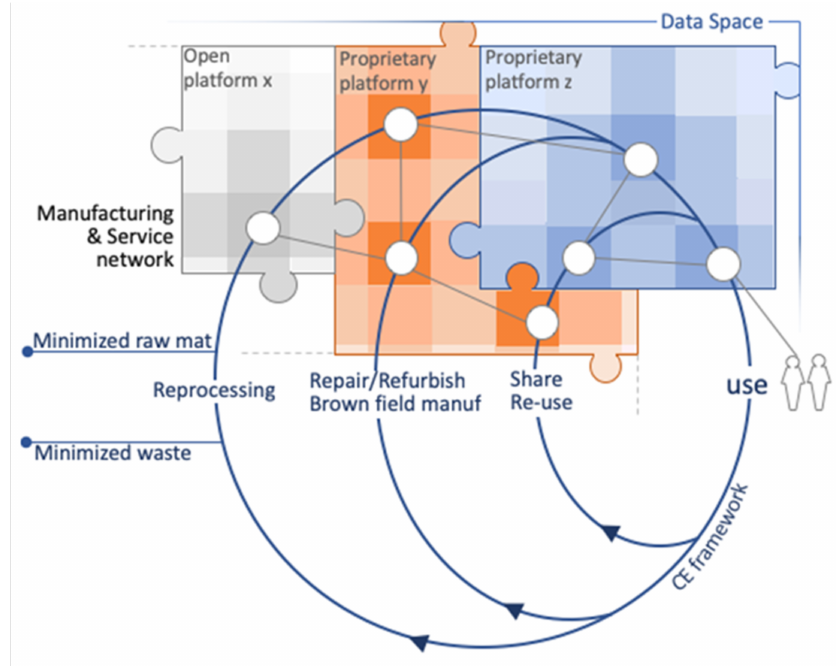
Figure 3. Manufacturing and service network in a circular